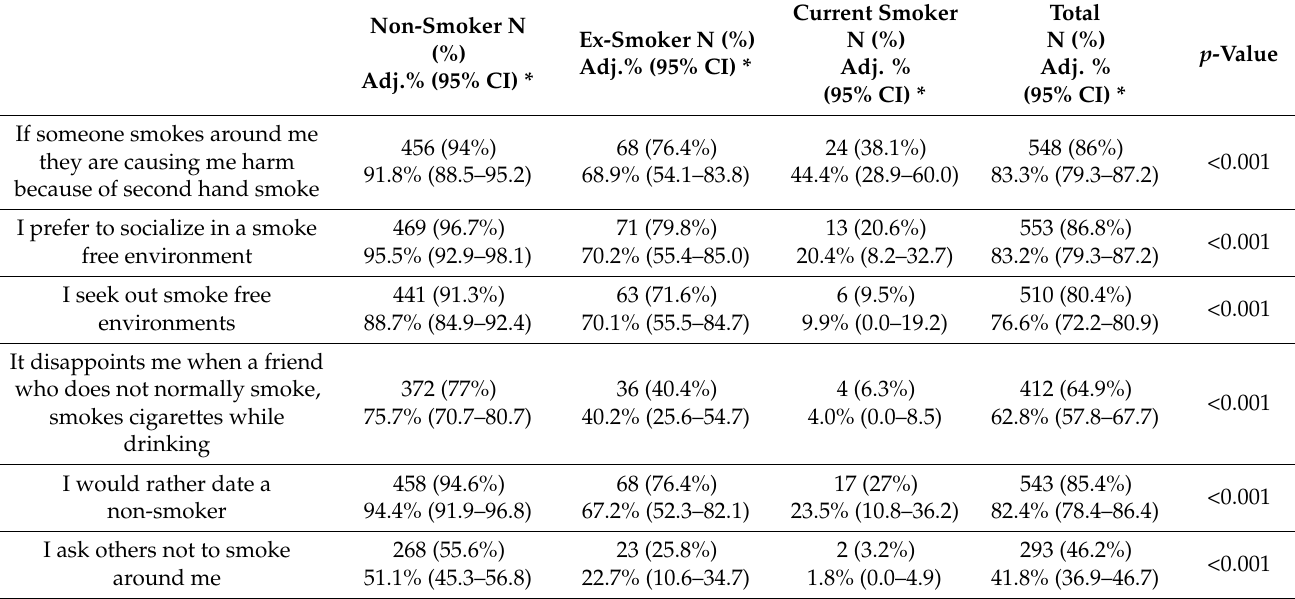
Table 2. Agreement with smoking attitude statements reported by university staff and students.